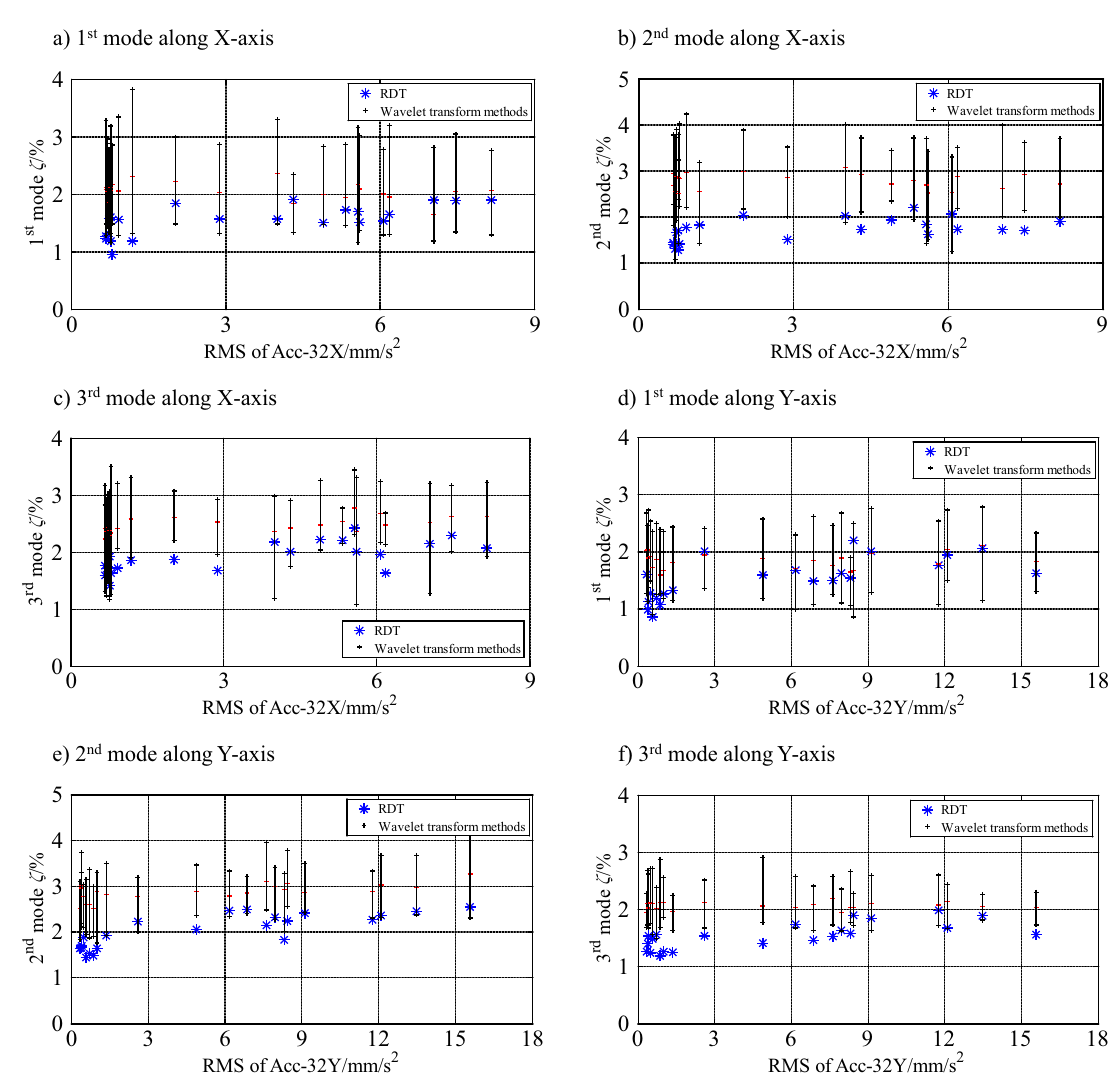
Figure 17. The relationship between modal damping ratios and RMS of Acc at the top